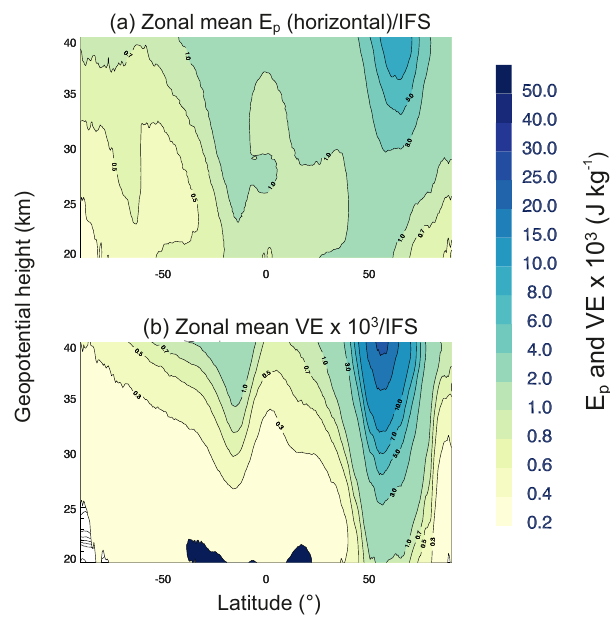
Figure 15. (a) Monthly mean zonal mean distribution of E P from IFS data derived after detrending in the horizontal with T42 IFS fields. (b) Monthly mean zonal mean distribution of VE = 1